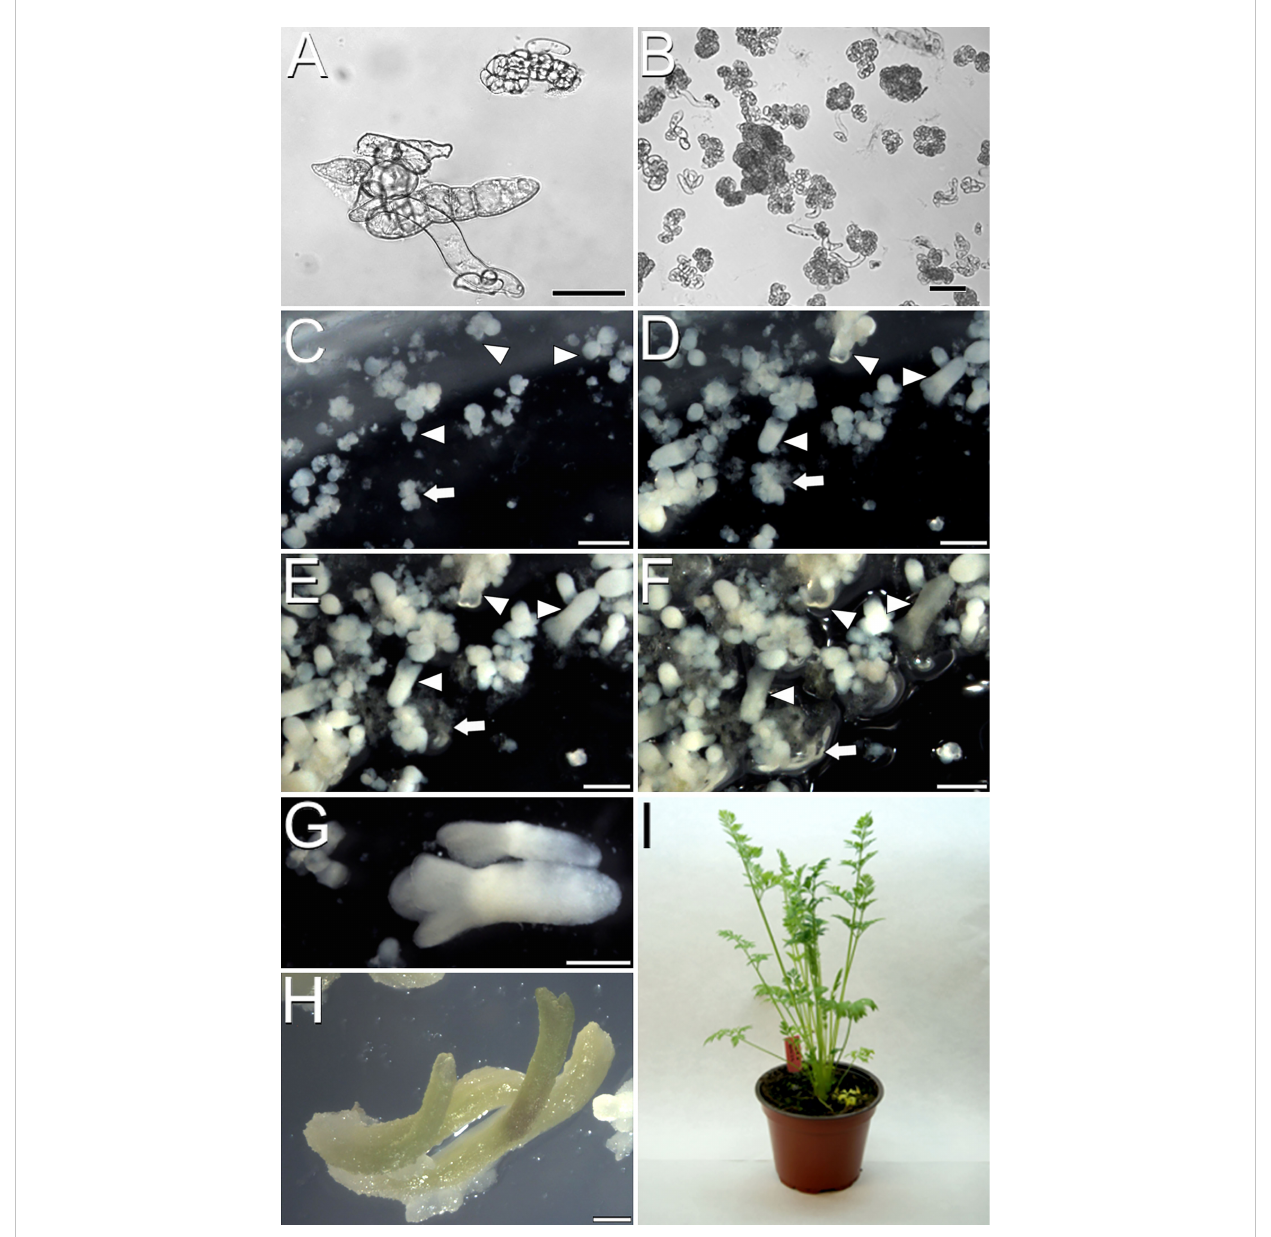
FIGURE 2 Carrot somatic embryogenesis. (A) Cell clumps after one week in liquid EIM. (B) Compact embryogenic masses after one week in liquid MS2%. (C-F) Time-lapse images of an immobilized culture one week (C) , two weeks (D) , three weeks (E) and one month after immobilization (F) . Arrowheads point to individual developing embryos progressing through different developmental stages. Arrows point to an individual proliferating callus mass. (G) Fully developed embryo after three weeks in liquid MS2%. (H) Embryos germinated in solid MS2%. (I) Acclimatized adult carrot plant regenerated from somatic embryos. Bars: (A, B) : 50 µm; C-H: 500